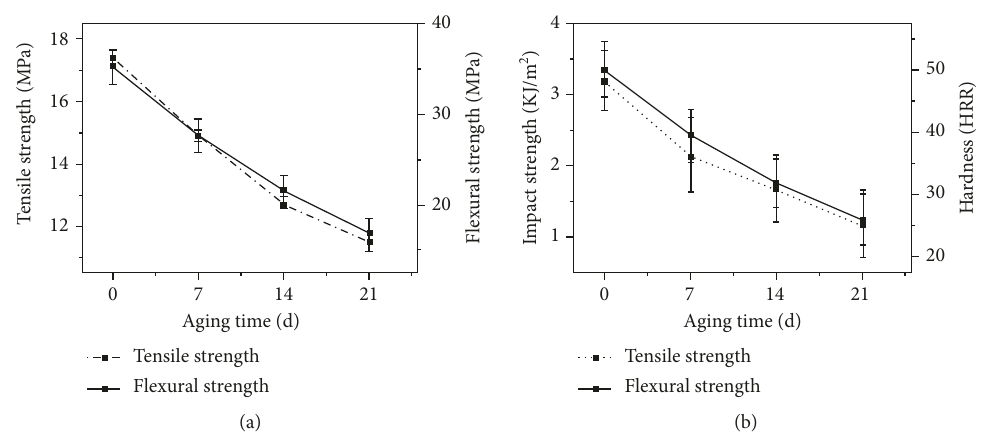
Figure 4: Physical and mechanical properties of the PVC/RHF composites.